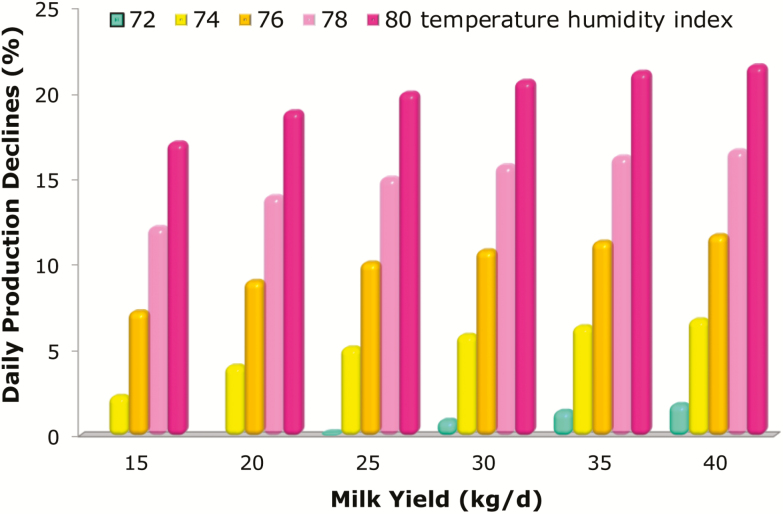
Daily production declines (%) at the increase of temperature–humidity index (Berry et al., 1964).